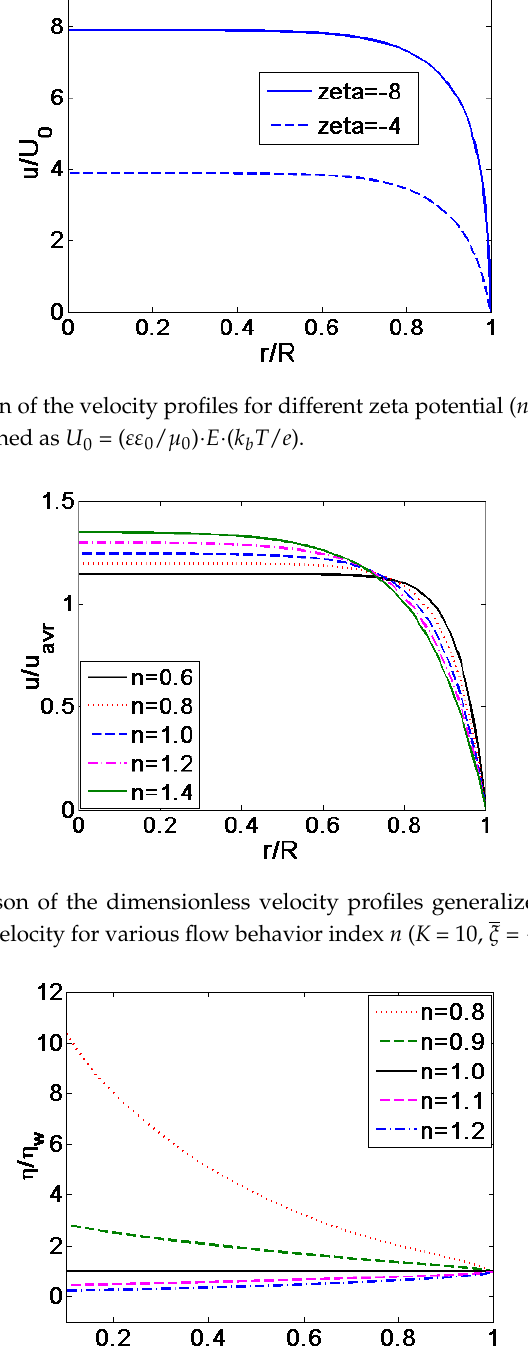
Figure 2. The comparison of the analytical solution with the numerical solution ( n = 1 and = − 1).